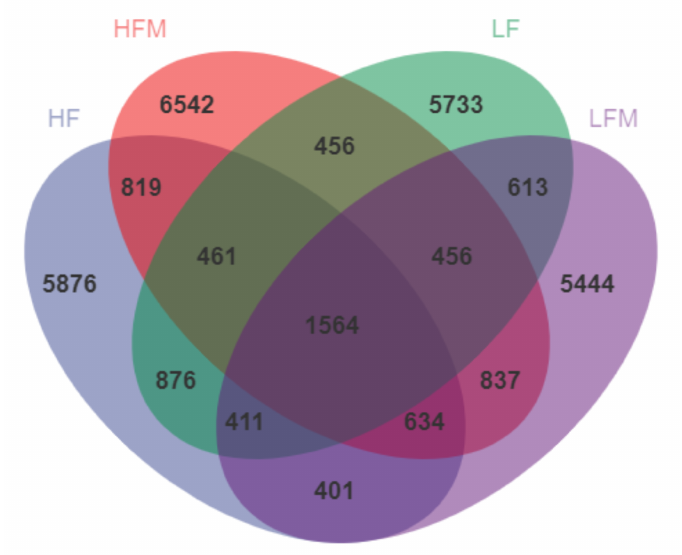
Figure 1. ASV/OTU Venn